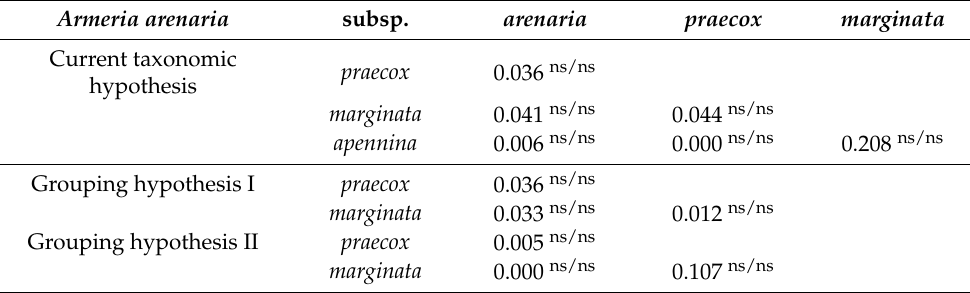
Table 7. Results of niche similarity tests in environmental spaces among the different taxa and circumscription hypotheses of Armeria arenaria . Backgrounds were defined by applying 10 km buffer zones around the occurrence points. Current taxonomic hypothesis as stated by Arrigoni [17], (I) = first alternative grouping hypothesis, (II) = second alternative grouping hypothesis. ns = not